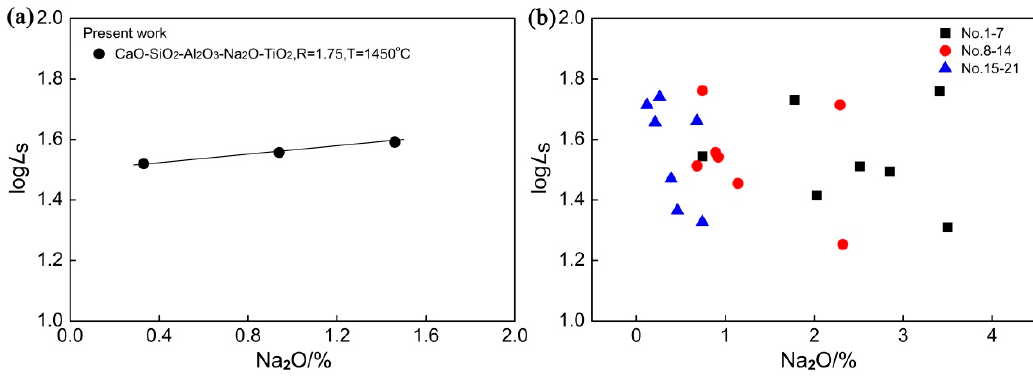
Figure 7. Effect of Na 2 O on log L S .